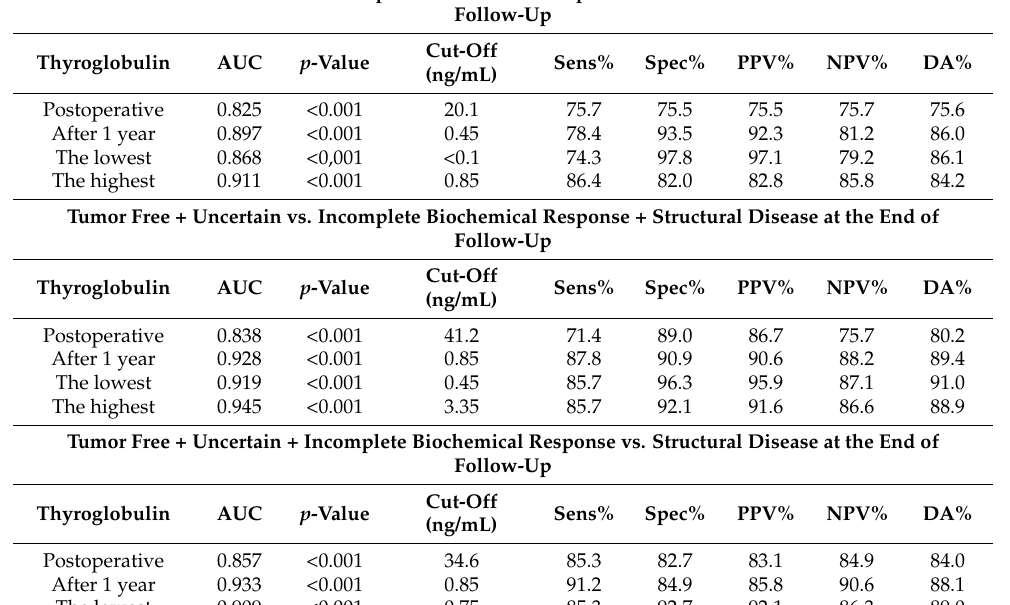
Table 5. The diagnostic benefit of thyroglobulin values in the prediction of therapeutic response (by ROC